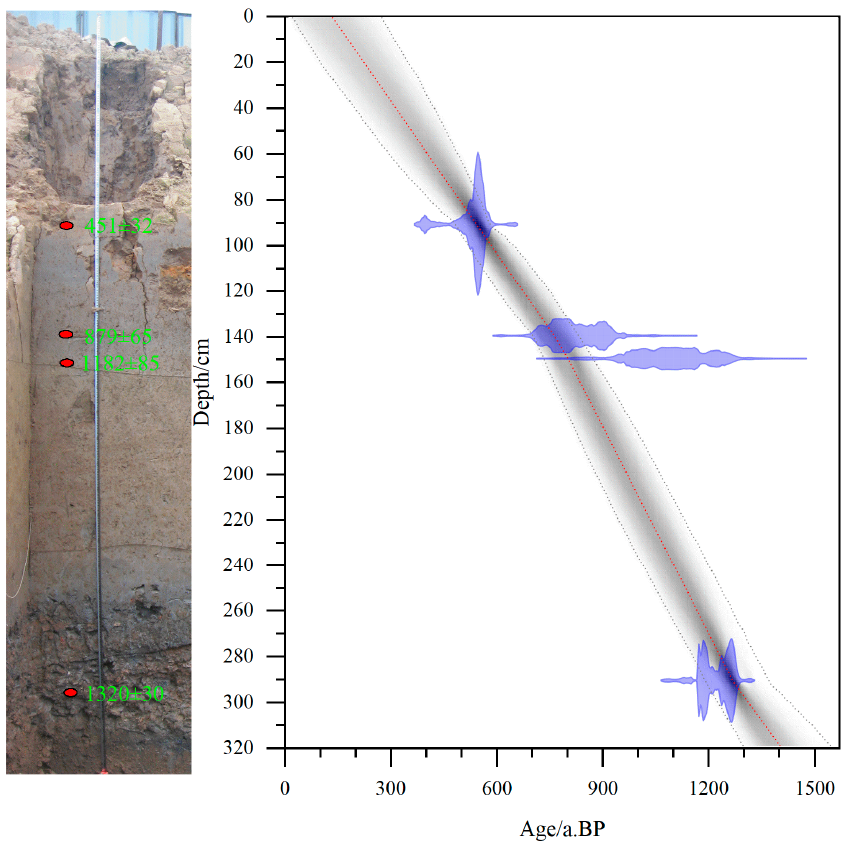
Figure 2. Stratigraphy and age − depth model of the SZP section, adapted from Tan’s result [29].